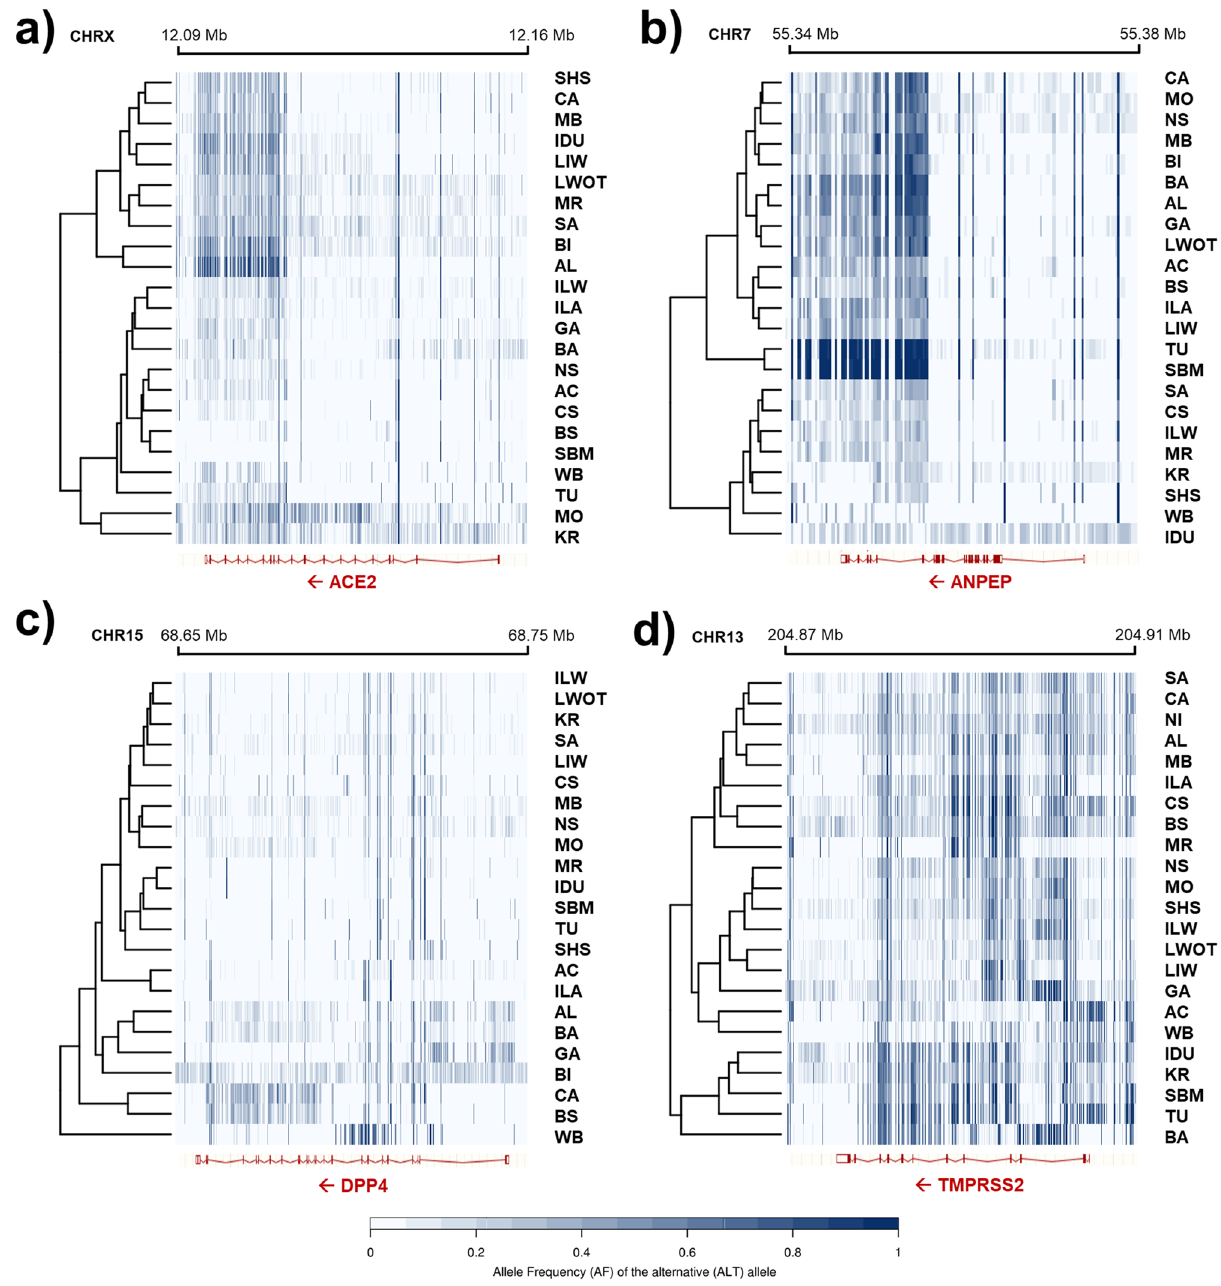
Figure 2. Representations of variant allele frequency values in the analyzed candidate genes plotted for each breed and position, considering the alternative (ALT) allele (defined considering the corresponding nucleotides on Sscrofa11.1 genome version). ( a ) ACE2 , ( b ) ANPEP , ( c ) DPP4 and ( d ) TMPRSS2 . Acronyms of the breed name are the following: Alentejana, AL; Apulo-Calabrese, AC; Basque, BA; Bísara, BI; Black Slavonian, BS; Casertana, CA; Cinta Senese, CS; Gascon, GA; Krškopolje, KR; Lithuanian Indigenous Wattle, LIW; Lithuanian White Old Type, LWOT; Majorcan Black, MB; Mora Romagnola, MR; Moravka, MO; Nero Siciliano, NS; Sarda, SA; Schwäbisch-Hällisches Schwein, SHS; Swallow-Bellied Mangalitsa, SBMA; Turopolje, TU; Italian Duroc, IDU; Italian Large White, ILW; Italian Landrace, ILA; Wild Boar,